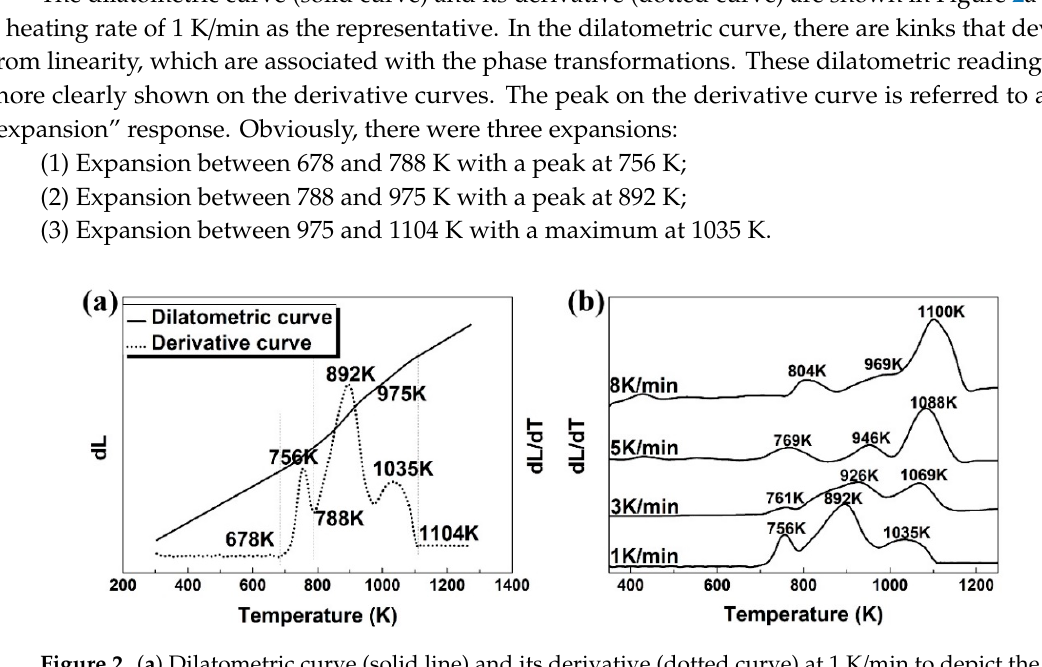
Figure 2. ( a ) Dilatometric curve (solid line) and its derivative (dotted curve) at 1 K/min to depict the length change with respect to temperature in the continuous heating. ( b ) Derivative dilatometric curves at heating rates of 1, 3, 5, and 8 K/min.